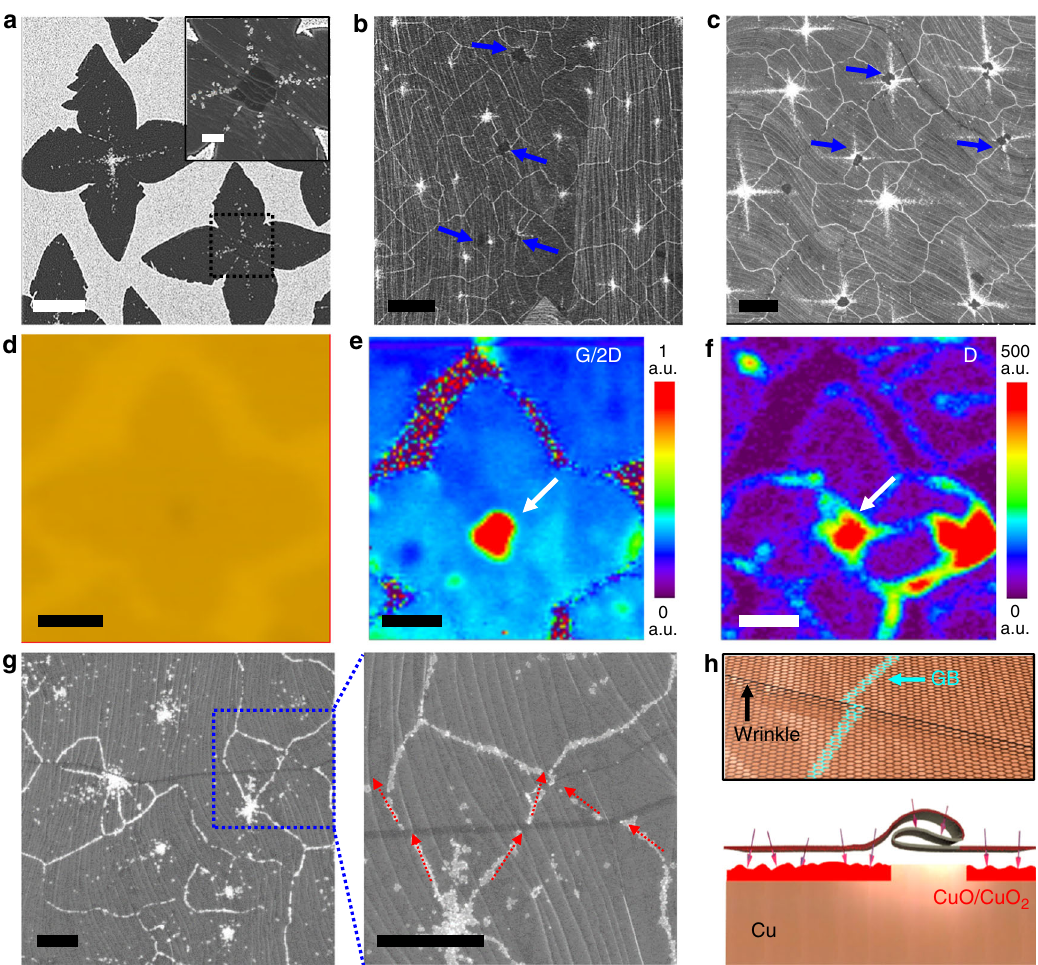
Fig. 3 Structural characterization of the oxidation behavior of Cu at the presence of multilayer graphene fl akes and folded wrinkles. a A representative SEM image of Gr islands grown on a Cu(100) grain, followed by annealing at ~200 °C for 120 min in air. The inset is a higher magni fi cation SEM image of the black-dotted square in a (scale bar = 1 μ m). Typical SEM images of the fully grown Gr/Cu sample after annealing at ~200 °C in air for b 120 and c 240 min. Blue arrows in b and c indicate the nucleation points of Gr covered by multilayer fl akes. d – f An OM image and corresponding Raman G/2D and D map images of a Gr island with a multilayer fl ake in the center, after being transferred onto SiO 2 /Si (from left to right). White arrows in e and f indicate the position of a multilayer Gr fl ake. g A typical SEM image of the fully grown, air-annealed Gr/Cu sample containing folded wrinkles, after annealing at ~200 ° C in air. The right is a higher magni fi ed SEM image of the blue-dotted square, and the red arrows indicate the presence of a kink in the oxidation line features at the folded-wrinkle regions. Scale bars = 5 µ m a – c , 2 µ m d – g . h Schematic diagram represents the effective anti-oxidation mechanism of